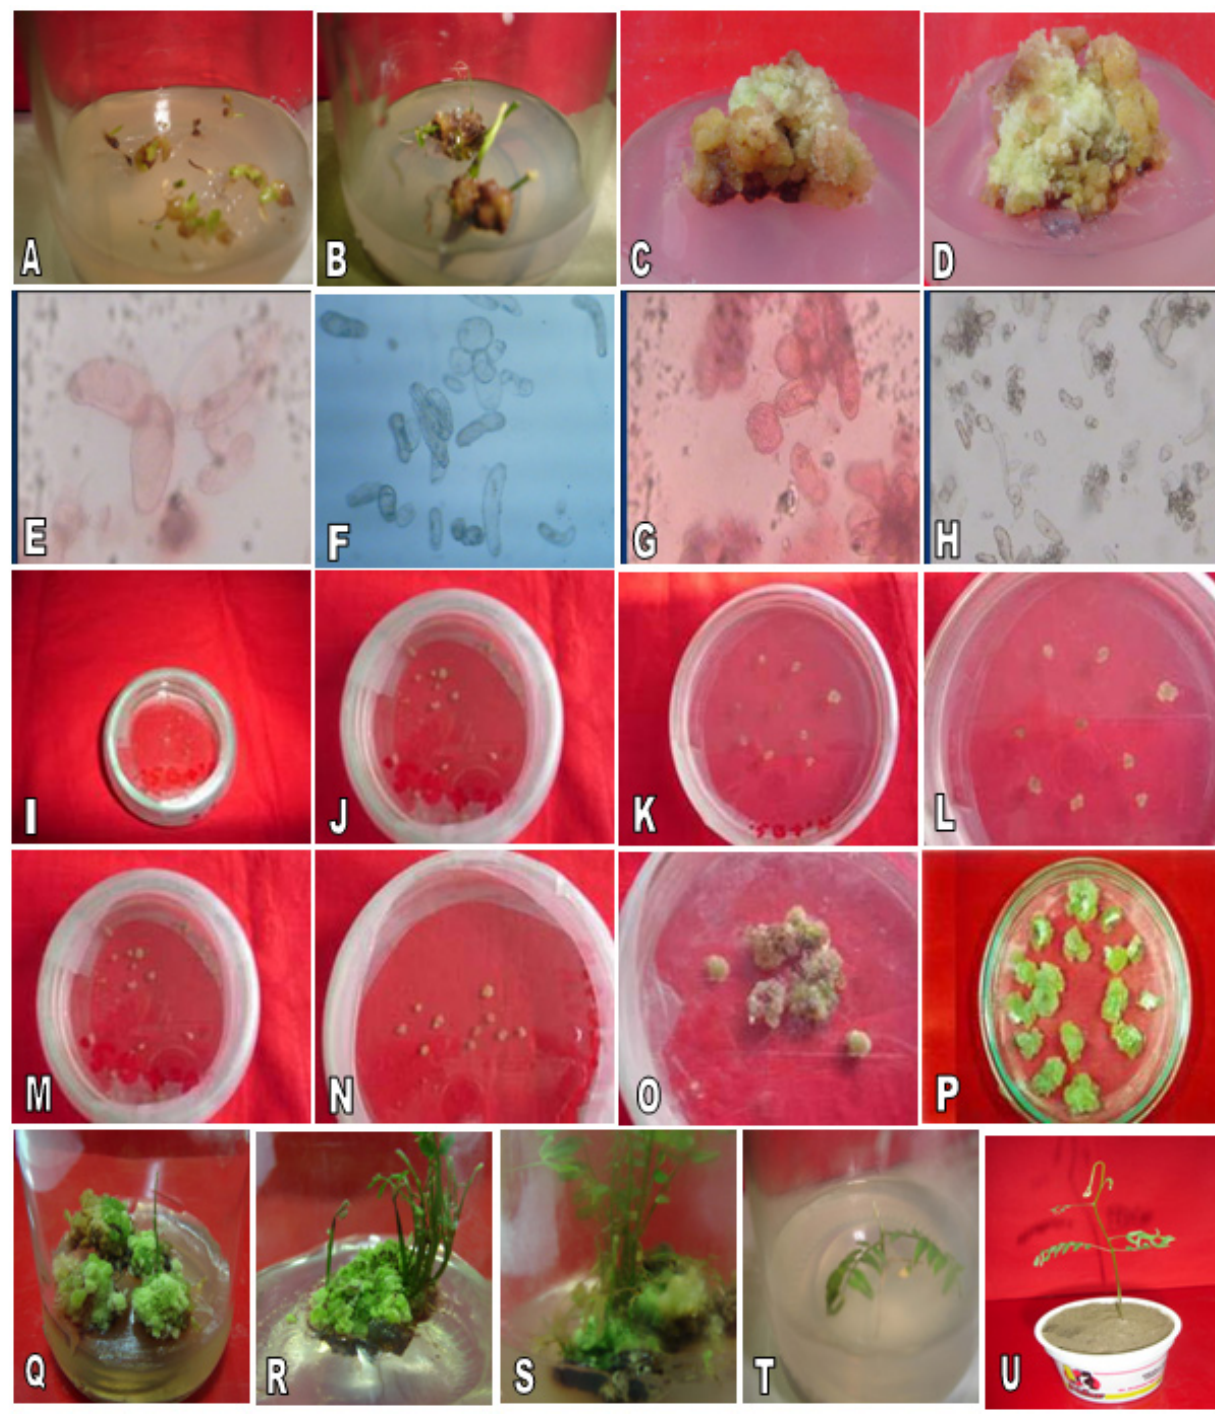
Fig. 1. Plant regeneration through cell culture. A: Callus induction of leaf explants; B: Callus induction of internodal explants; C-D: Development of callus; E-F: Single Cells of A. precatorius ; G-H: Divisional stage of cells; I: Leaf cell derived callus in MS liq- uid medium with BAP; J: Internodal cell derived callus in MS liquid medium with BAP; K-L: Leaf cell derived callus in MS liquid medium with BAP+NAA combination; M-N: Internodal cell derived callus in MS liquid medium with BAP + NAA combination; O-P: Embryo formation from leaf derived callus in MS solid medium in BAP + NAA combination; Q-S: Shoot formation from mature embryos in shooting medium; T: Root formation from embryo derived shoot in rooting medium; U: Established plant in natural